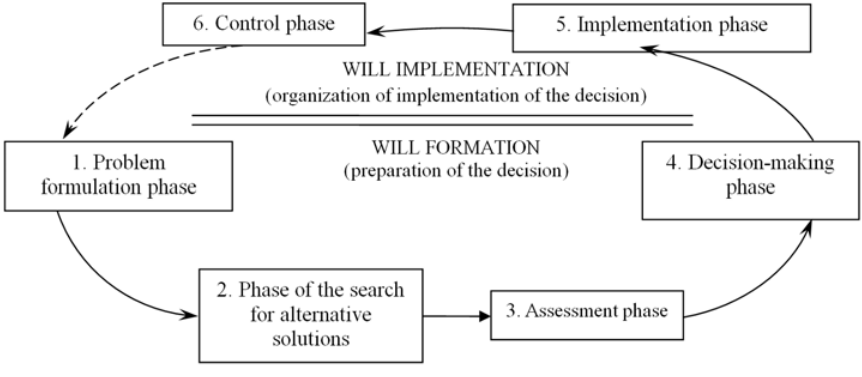
Fig. 6. Control as a process (management